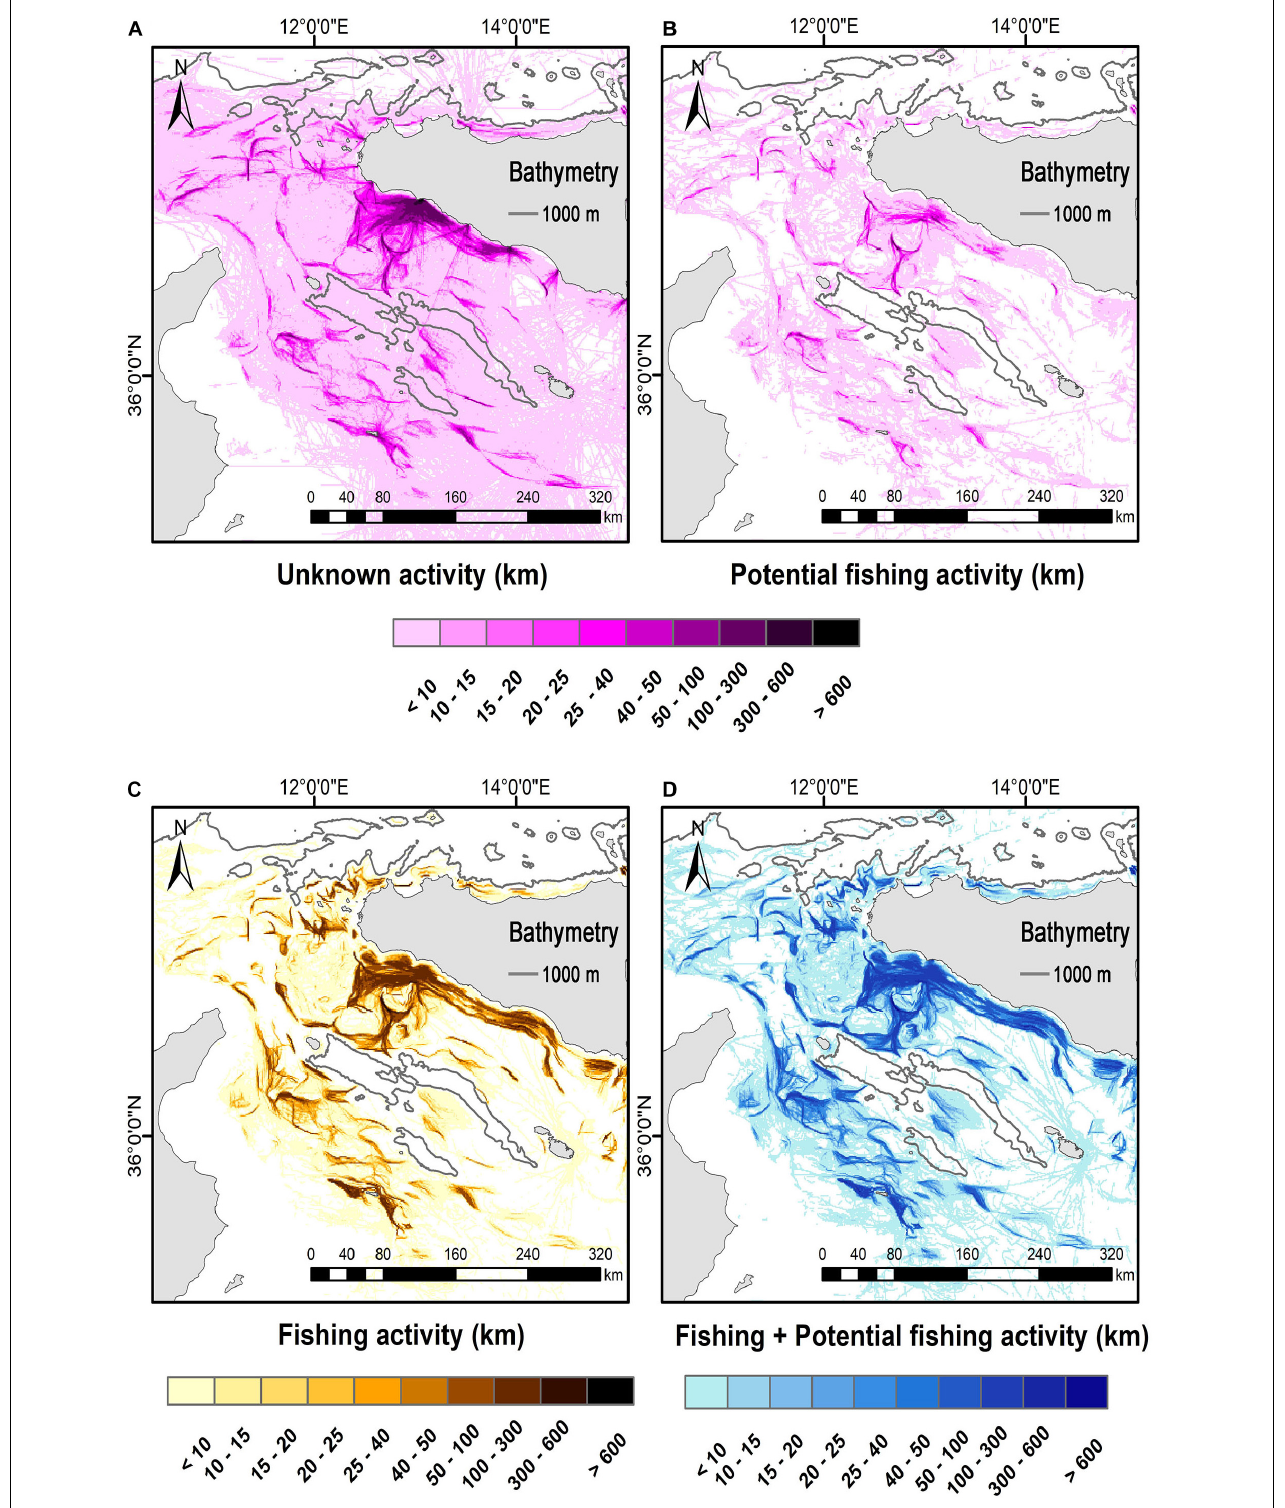
FIGURE 5 | Unknown annual activity (A) , potential (B) , known (C) , and total (known + potential) annual fishing activity (D) in the Strait of Sicily (2014).